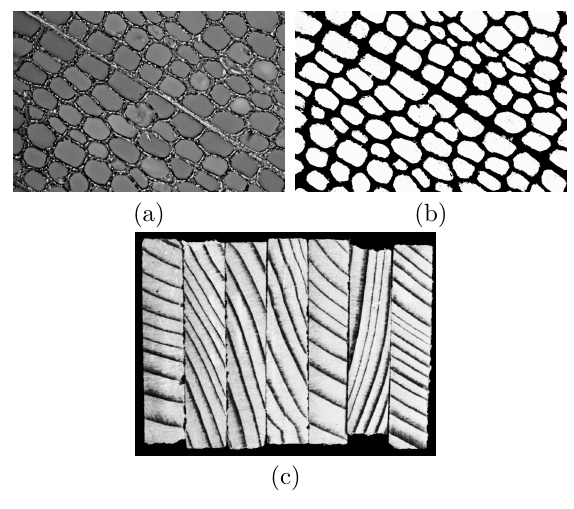
Figure 2. a) Original gray-scale image of earlywood, b) Transformed binary image of earlywood, c) Images of growth rings.